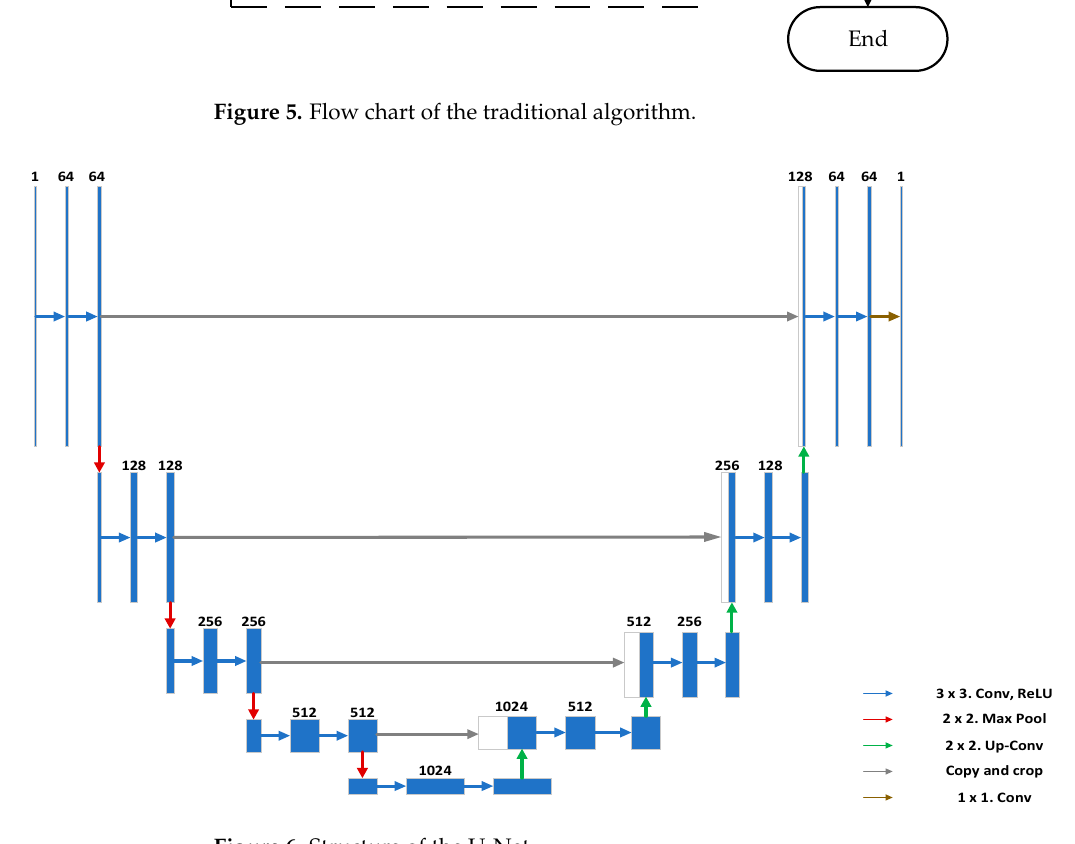
Figure 6. Structure of the U-Net.